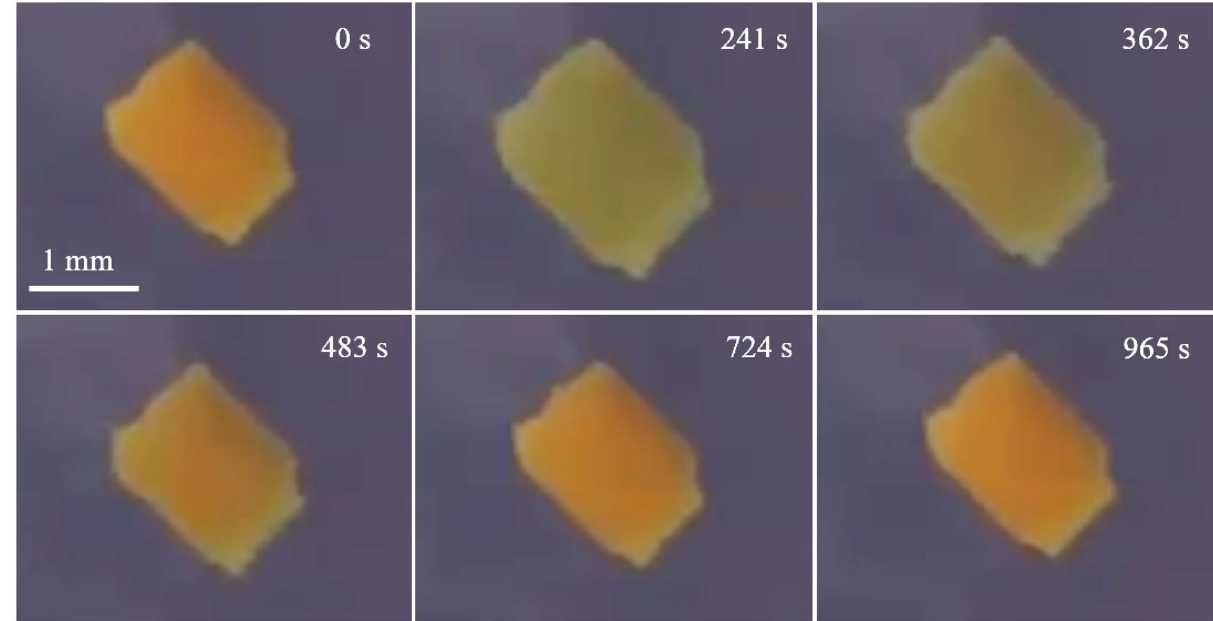
Figure 1. Snapshots of the BZ gel’s oscillation. Top right shows the time